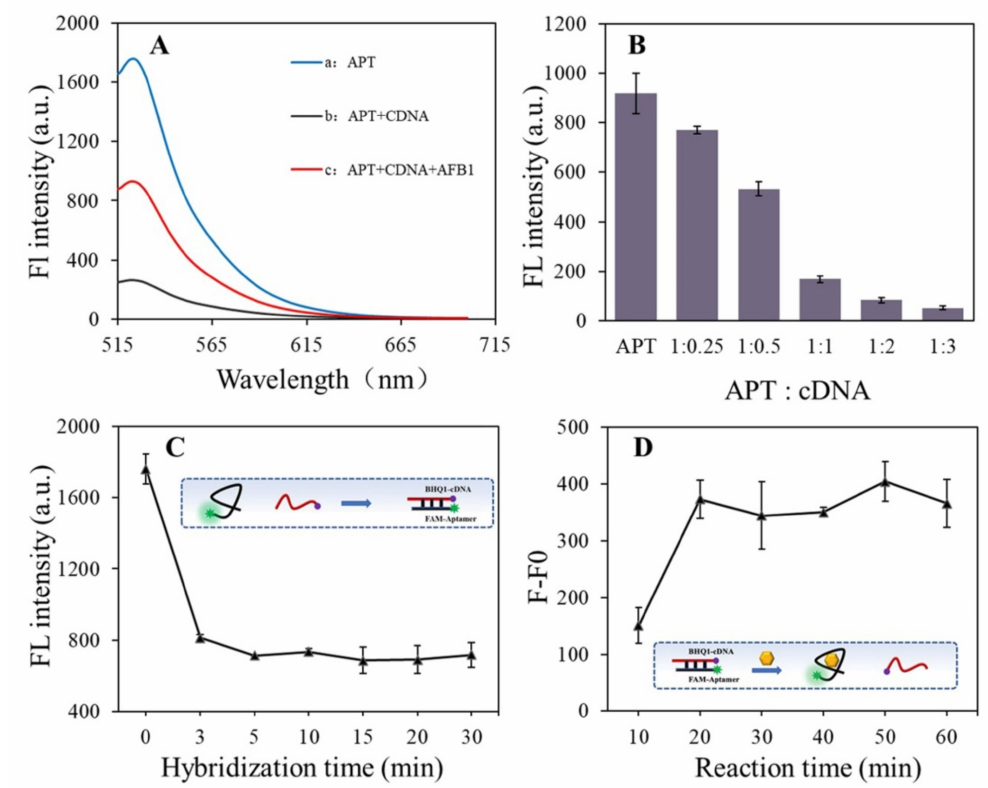
Figure 2. ( A ) Fluorescence effect of FAM-aptamer and BHQ1-cDNA in the structure-switch displace- ment assays. ( B ) Optimization of the hybridization ratio of aptamer and cDNA. ( C ) Optimization of the hybridization time of aptamer and cDNA. ( D ) Optimization of the reaction time between the aptamer–cDNA and AFB1. F and F0 are respectively the fluorescence intensity in the presence and absence of